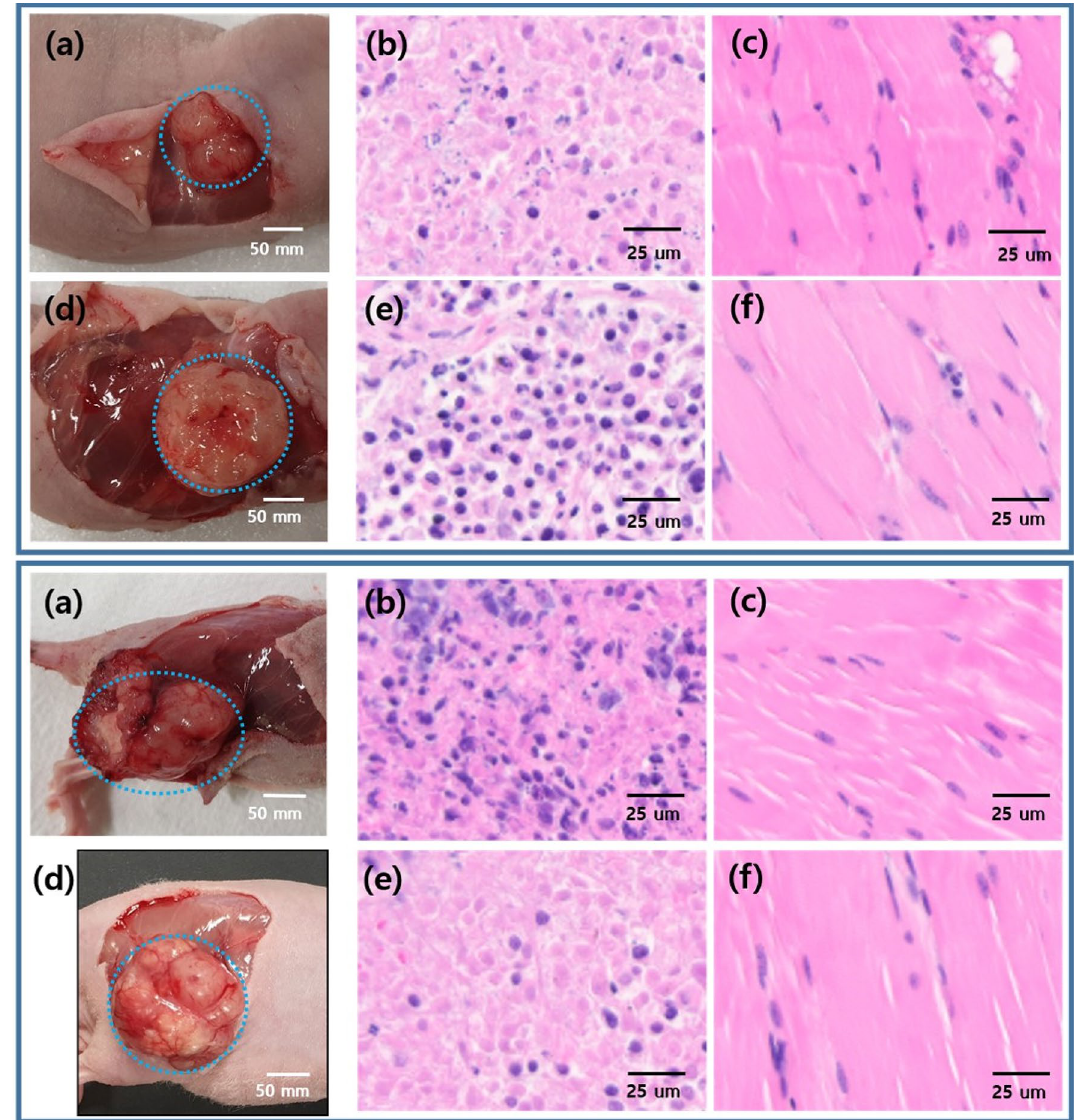
Figure 5. ( a ) Images of the breast cancer model (Top: MDA-MB-361 cell line) and skin cancer model (Bottom: A375 cell line). Hematoxylin and eosin (H&E) staining results of tissues of the normal group ( b ) and tumor group ( c ). Compared with tissues in the normal group, those in the tumor group showed cell and nuclear